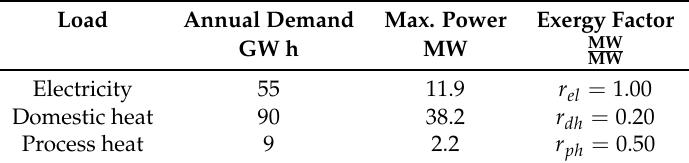
Table 3. Loads: annual demand, maximum power and exergy